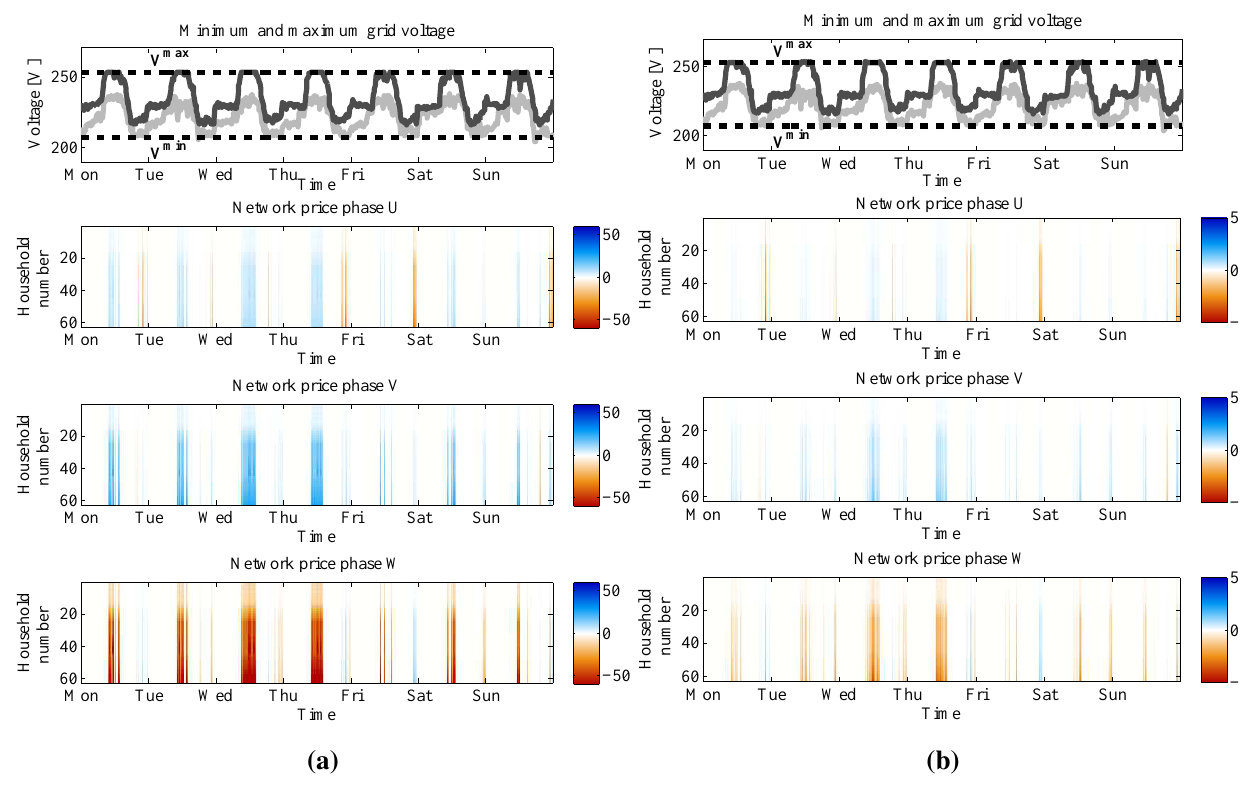
Figure 9. The maximum and minimum phase voltage that occurs in the control nodes and the network price at each node for active power during a sunny week in the case of active power curtailment only (a) and both active power curtailment and reactive voltage control (b) . Note that the price scale is